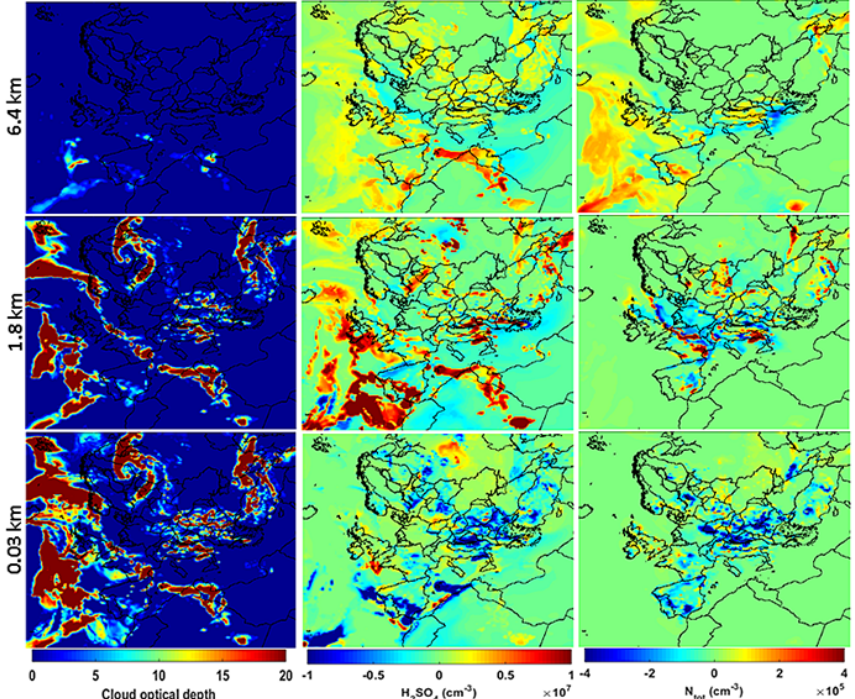
Figure 5. Left column: the total cloud optical depth supplied by the WRF meteorology model. Middle column: the absolute difference between the predictions using the TUV (the simulation ACDC-TUV-DE; see Table 1) and RADM (the simulation ACDC-RADM-DE) radiative-transfer schemes within PMCAMx-UF for H 2 SO 4 concentration. Right column: absolute difference between prediction using TUV and RADM schemes for total particle number concentrations N tot . The parameters shown in the figure are snapshots on 5 May 2008 at 12:00UTC at model layers 1 (midpoint altitude: 0.03km), 9 (midpoint altitude: 1.7km), and 12 (midpoint altitude: